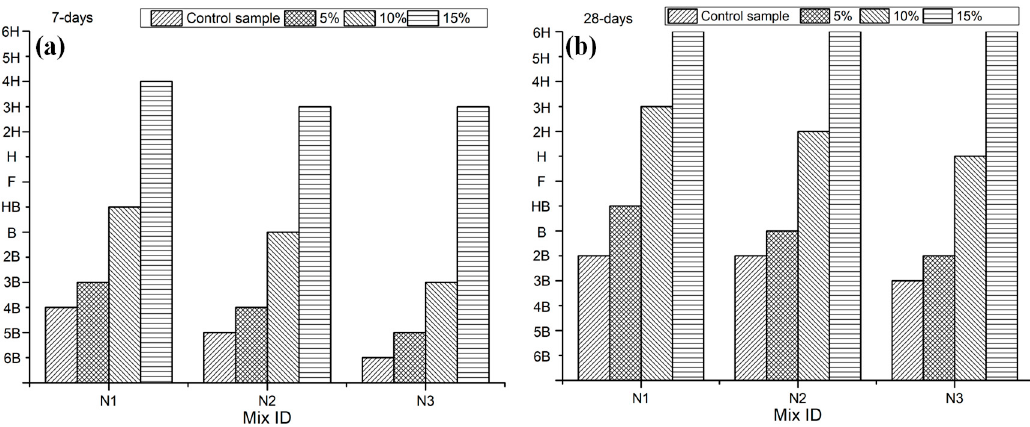
Figure 4. Effect of LS on the hardness of NHL-based mortar. ( a ) Modification after 7-days of curing. ( b ) Modification after 28-days of curing.